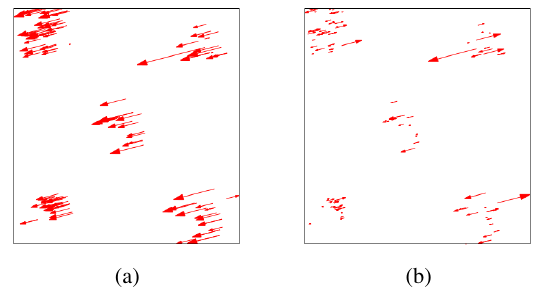
and the line i Figure 7: Error vectors for some keypoints on a 1000 × 1000 tile of a Pléiades image. (a) Error vectors before correction. (b) Error vectors after correcting the position of the second image by the optimal translation T ∗ .